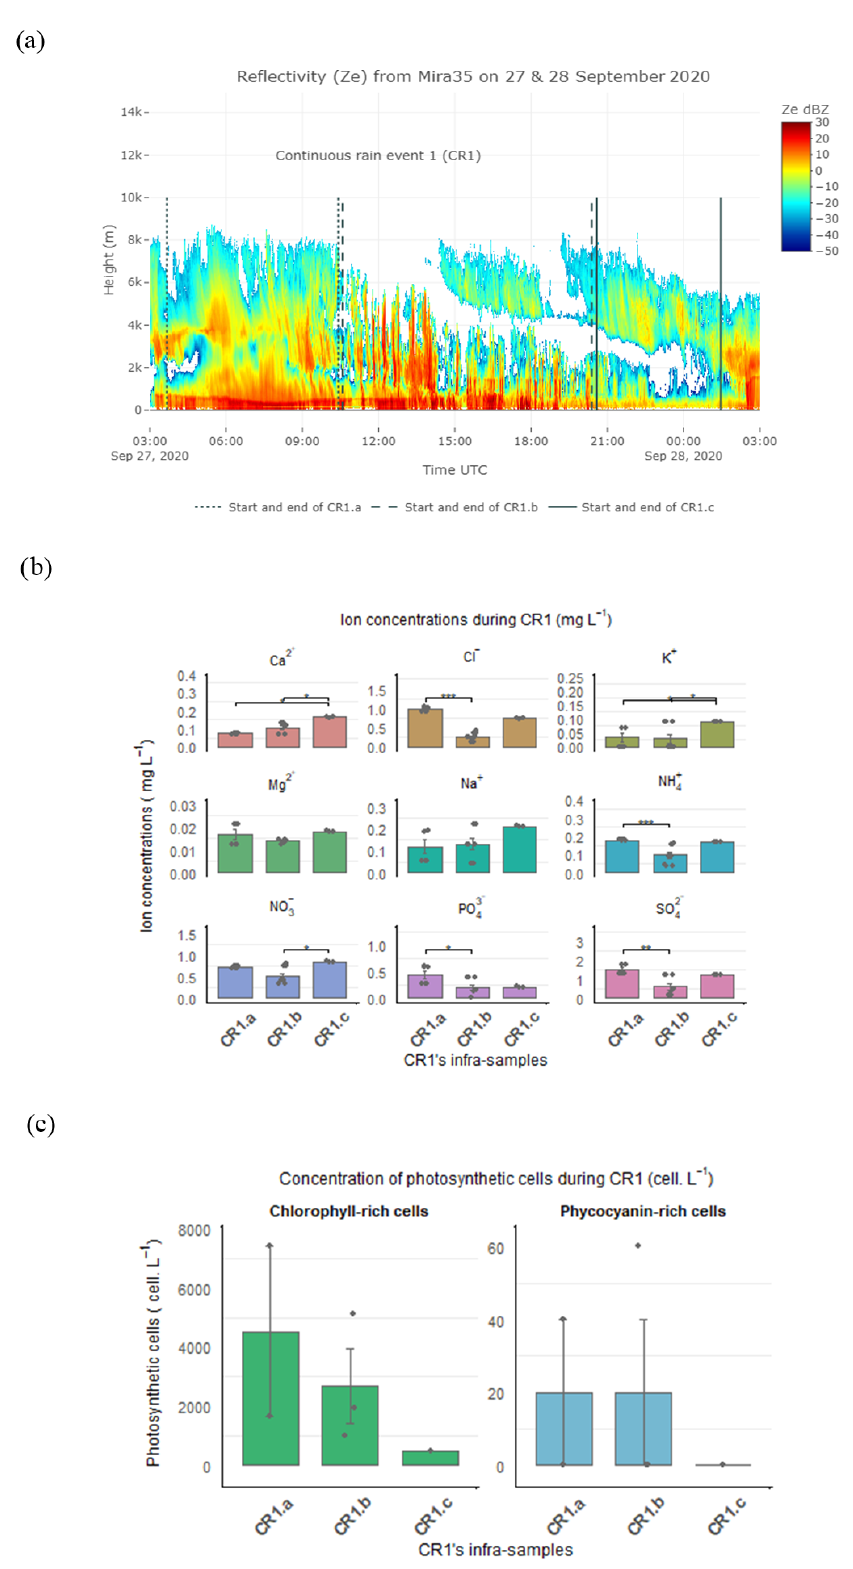
Figure 6. (a) CR1 event divided into three sub-periods based on the evolution of the reflectivity ( Z ) from Mira35c. (b) Inorganic nutrient concentrations (mgL − 1 ). (c) Photosynthetic cell concentrations (cells L − 1 ) in CR1 sub-events. The significance level from the Dunn test is shown to compare the nutrient concentration between the CR1